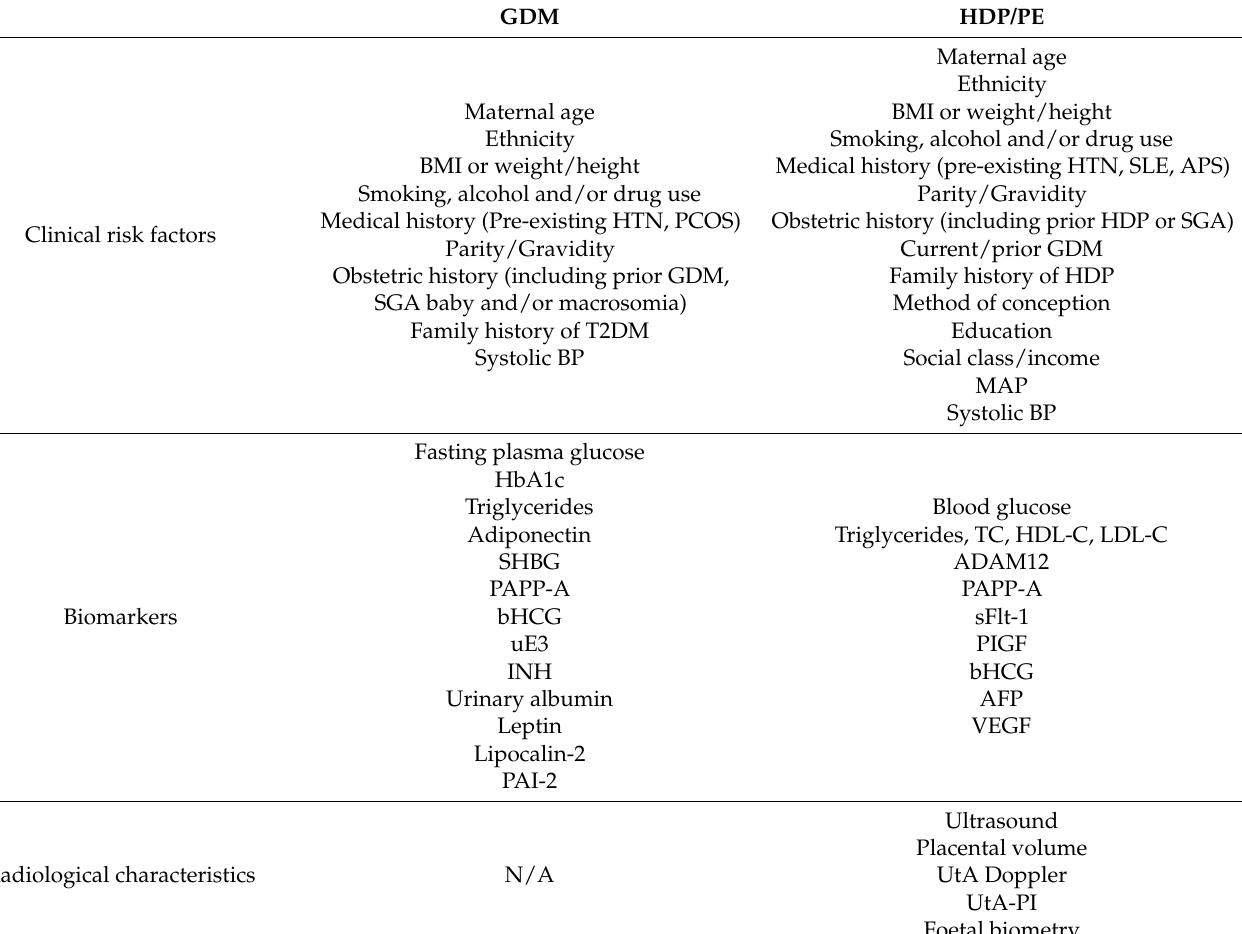
Table 1. Candidate predictors for GDM and